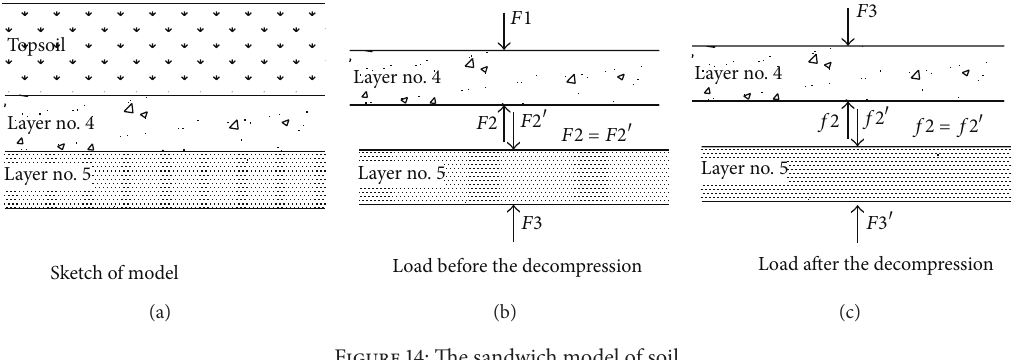
Figure 14: The sandwich model of